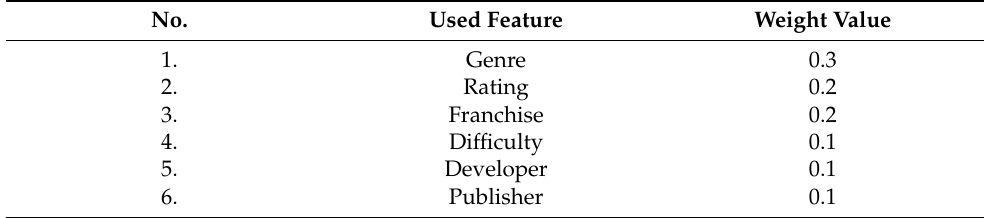
Table 2. Similarity weight